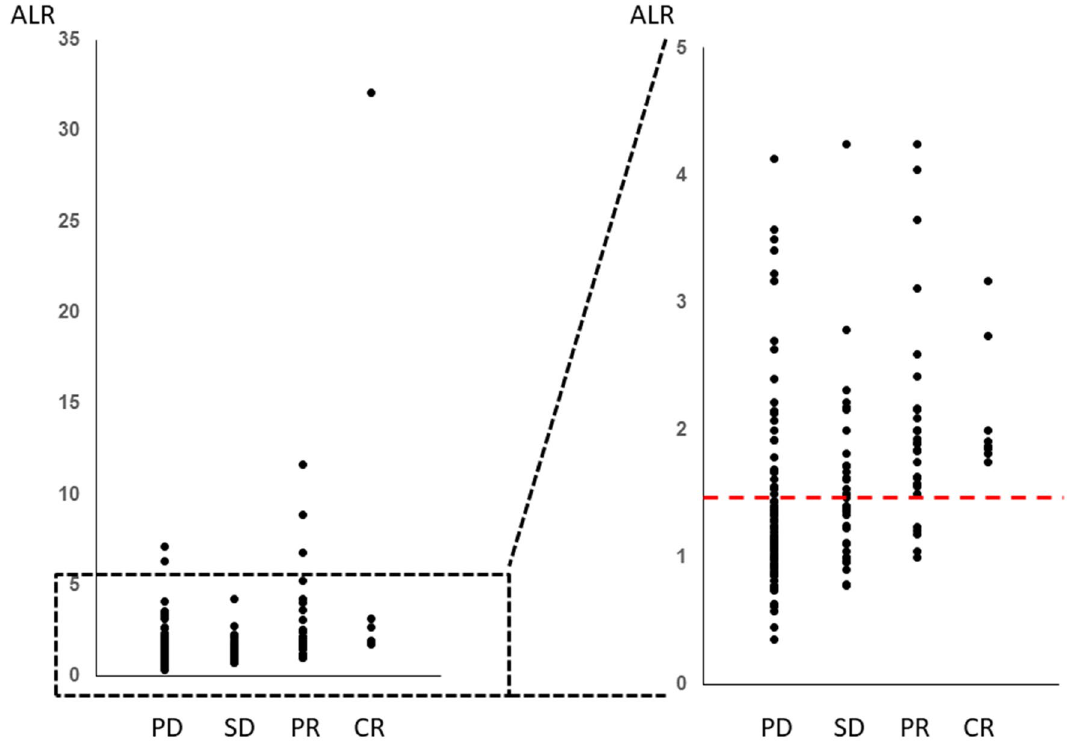
Figure 3. ALR according to the response to immunotherapy ( CR complete response; PR partial response; SD stable disease; PD progressive